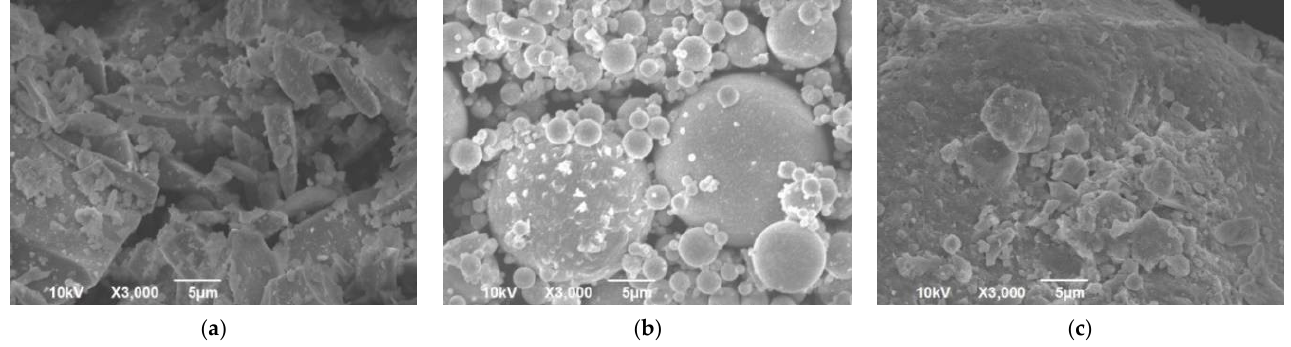
Figure 3. XRD spectrum of ( a ) slag, ( b ) fly ash, and ( c ) dune sand. Dune sand (Figure 1c) served as the fine aggregates in the geopolymer concrete mixes. Its morphology, phase analysis, and particle size distribution, shown in Figures 2c, 3c and 4c, respectively, highlight the predominant presence of SiO 2 in the form of angular particles. As shown in Table 1, it is characterized by a specific surface area of 117 cm 2 /g and specific gravity of 2.77. Furthermore, natural crushed dolomitic limestone aggregates (NA), with an NMS of 20 mm, were used as coarse aggregates. Their physical properties are presented in Table 2. It is composed of 59% CaO, 32% MgO, 6% SiO 2 , 1.6% Al 2 O 3 , and 1.4% other oxide compounds.